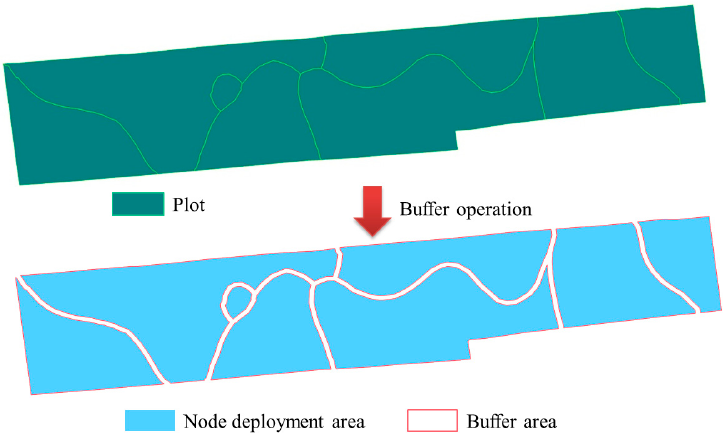
Figure 11. The diagram of generating node deployment area from farmland by GIS buffer operation.